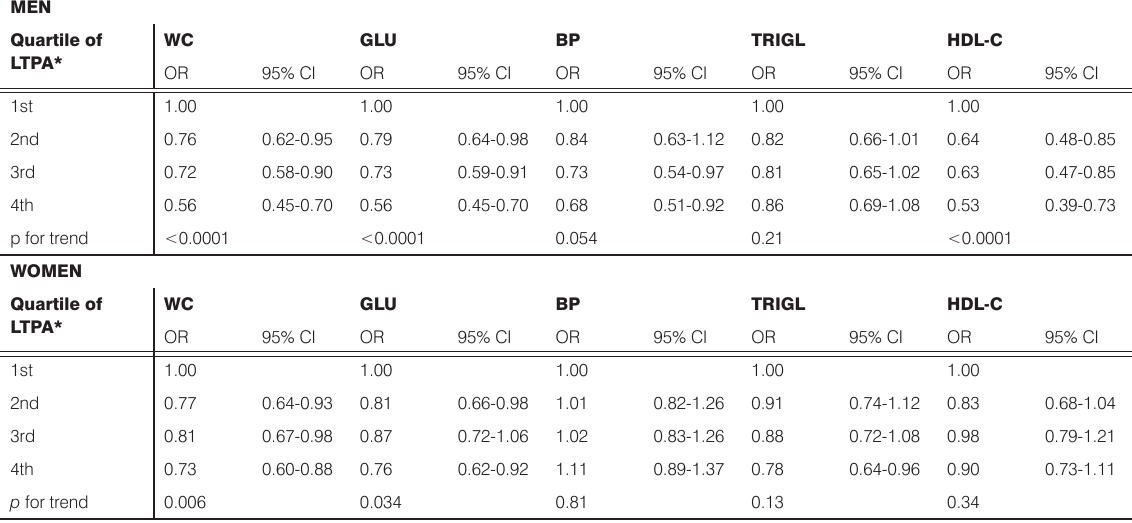
Table 4. Adjusted odds ratios 1 of the metabolic syndrome components in different levels of leisure-time physical